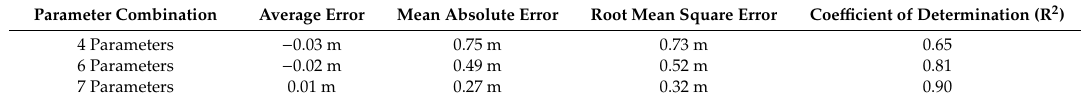
Table 2. Comparison of simulation accuracy of three models.